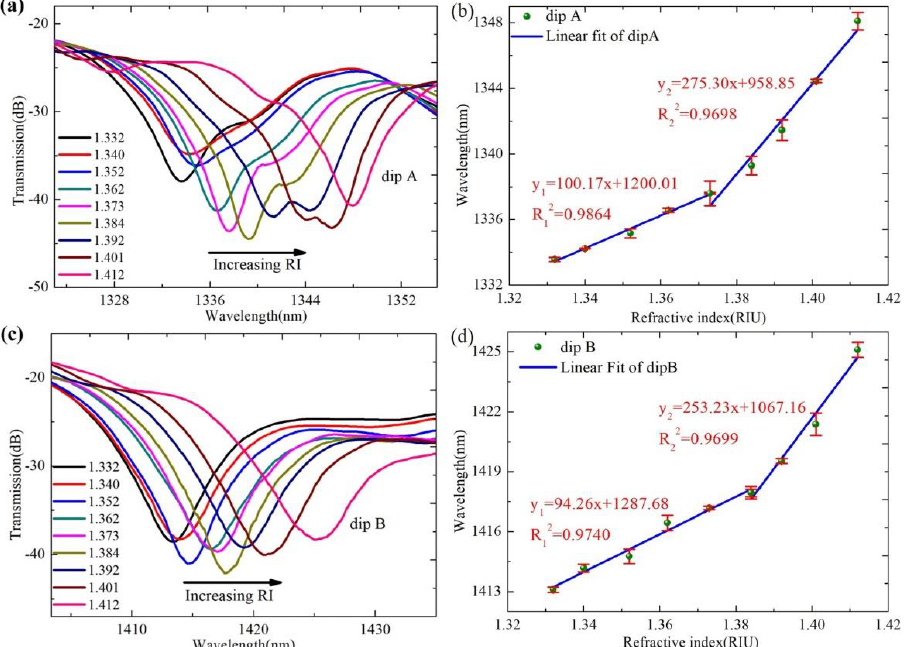
Figure 6. ( a ) The transmission spectra of dip A at different RI; ( b ) the wavelength shift trends of dip A under different RI; ( c ) the transmission spectra of dip B at different RI; and ( d ) the wavelength shift trends of dip B under different RI.